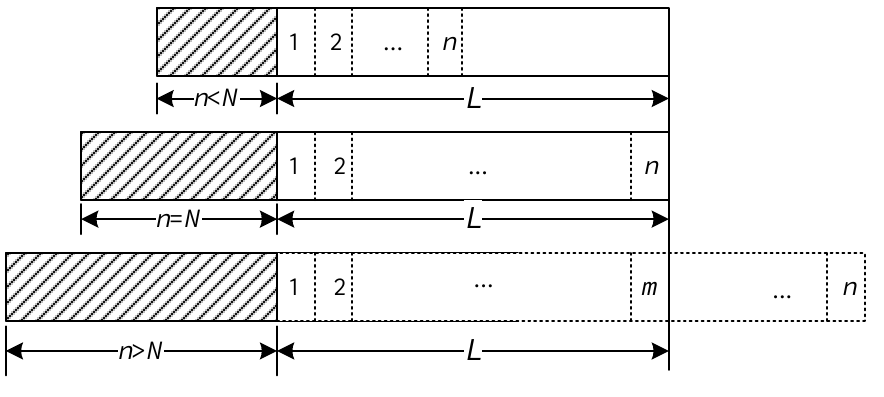
Figure 4. Recognition process in a single